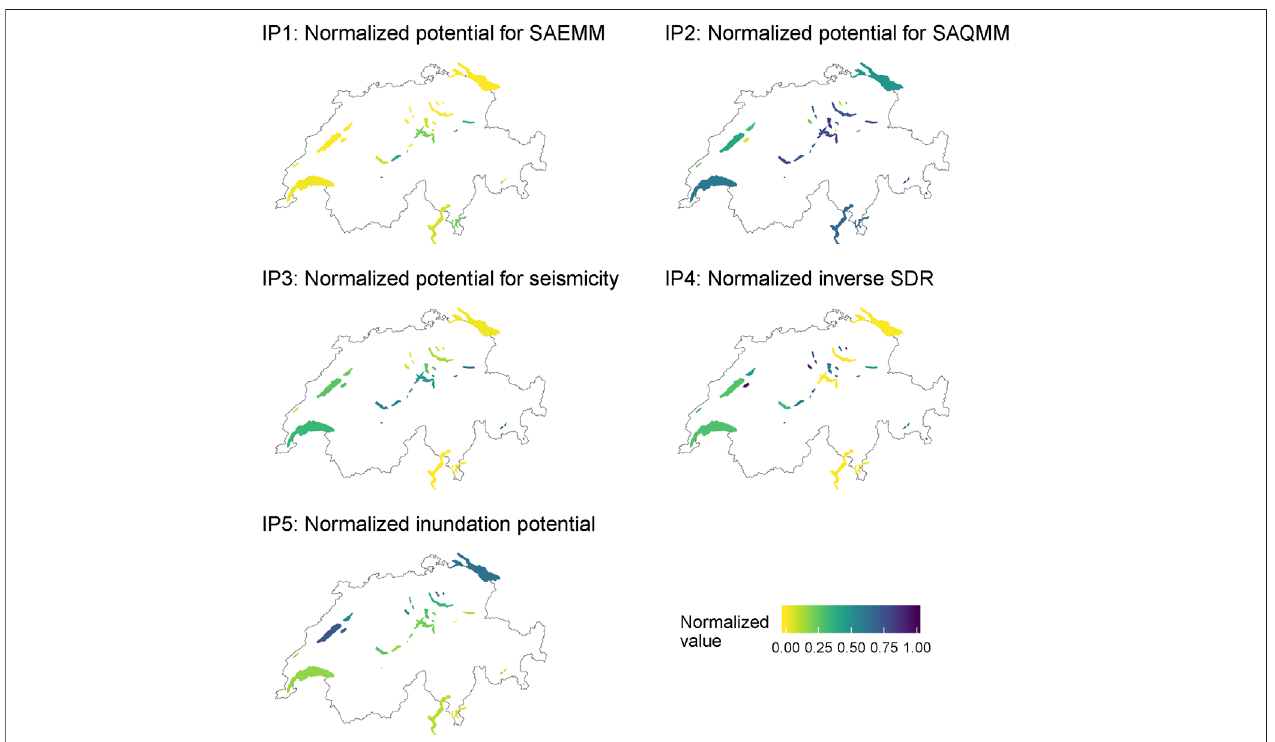
FIGURE 2 | Spatial distribution of the normalized input